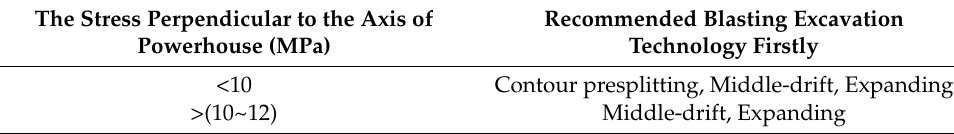
Table 6. The recommended blasting technology according to in situ stress condition. The Stress Perpendicular to the Axis of Recommended Blasting Excavation Powerhouse (MPa) Technology Firstly <10 Contour presplitting, Middle-drift, Expanding >(10~12) Middle-drift,